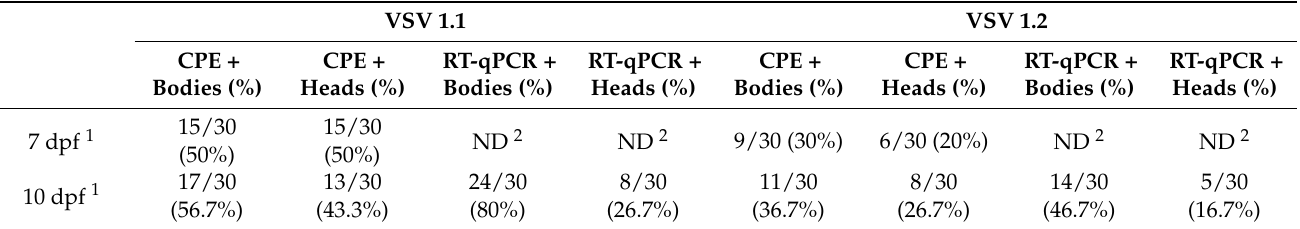
Table 1. VSV detection by CPE of orally infected Culicoides midges. VSV